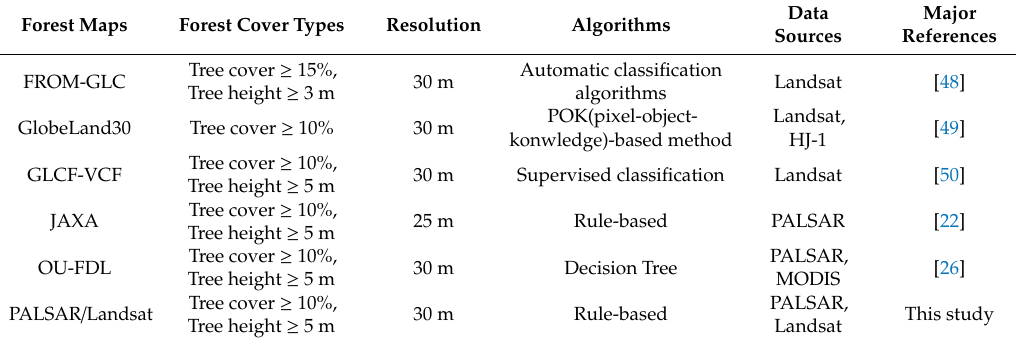
Table 2. Summary of forest products for the comparison in the Loess Plateau in 2010.